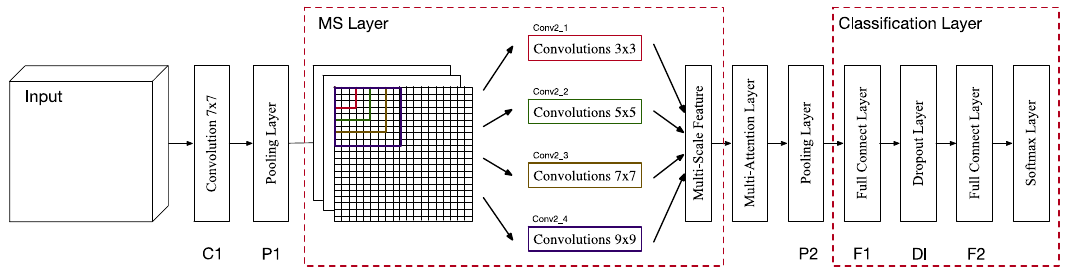
Figure 7. The topology of the shallow multi-scale convolutional neural network with multi-attention (MA-MSCNN). C1 is the first convolution layer with 32 filters with a size of 7 × 7. The MS layer as the second convolution layer includes four convolution layers of 64 filters with a size of 3 × 3, 64 filters with a size of 5 × 5, 64 filters with a size of 7 × 7, and 64 filters with a size of 9 × 9. The classification layer includes two fully connected layers with 1024 units, and the dropout layer between two fully connected layers avoids overfitting with a 50% dropout rate. Table 1. The details of the architecture of the shallow multi-scale convolutional neural network with multi-attention